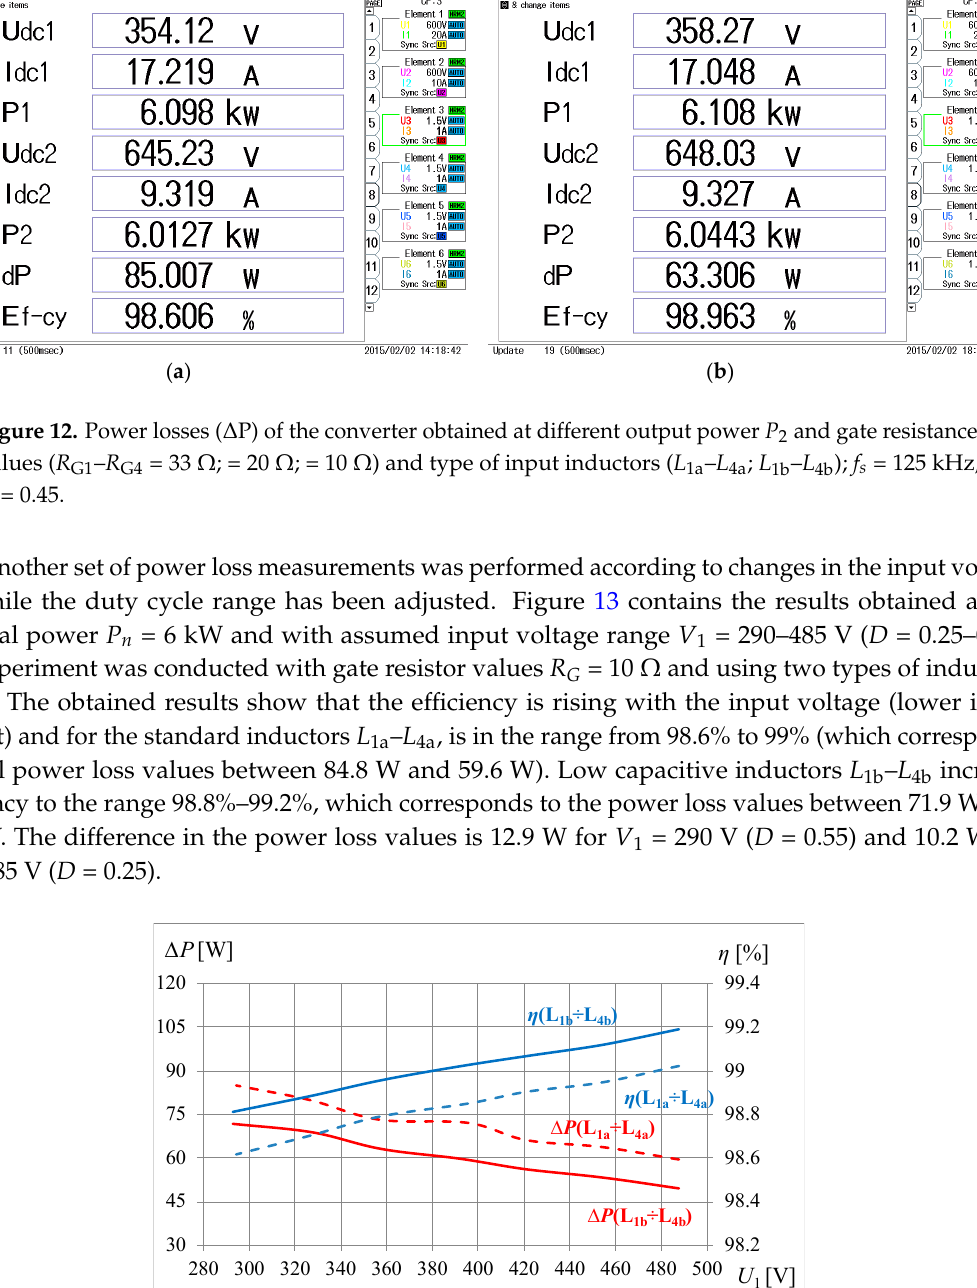
Figure 11. Power losses ( Δ P) of the converter obtained at various output power P 2 values and gate resistance values ( R G1 – R G4 = 33 Ω ; = 20 Ω ; = 10 Ω ) and different types of input inductors ( L 1a – L 4a ; L 1b – L 4b ); f s = 125 kHz, D = 0.45.